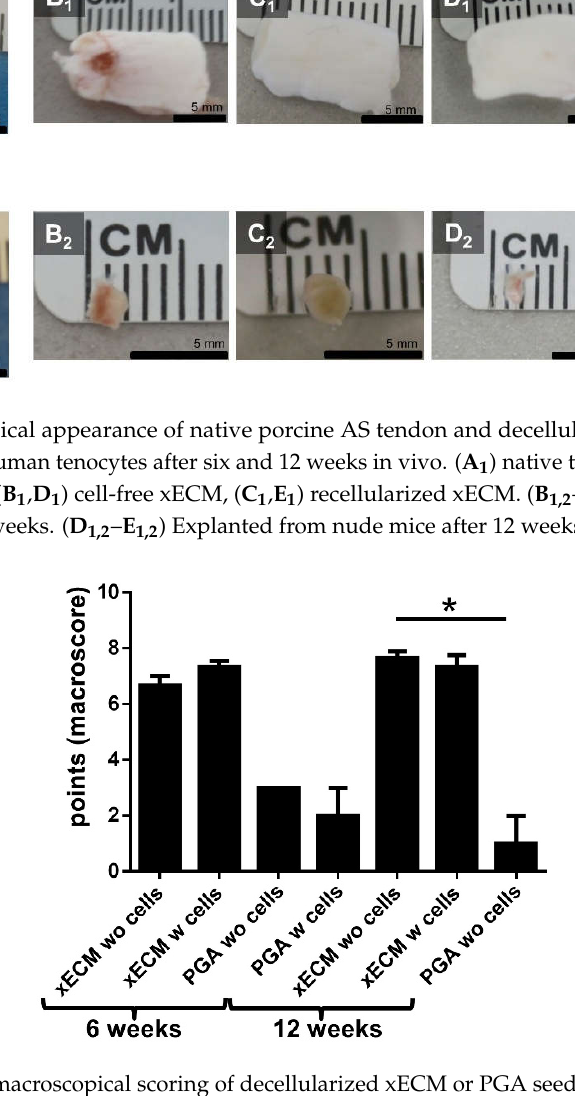
Figure 3. Results of macroscopical scoring of decellularized xECM or PGA seeded or not with human tenocytes after six and 12 weeks in vivo. PGA: polyglycolic acid. w: with, wo: without cells. * p < 0.05.